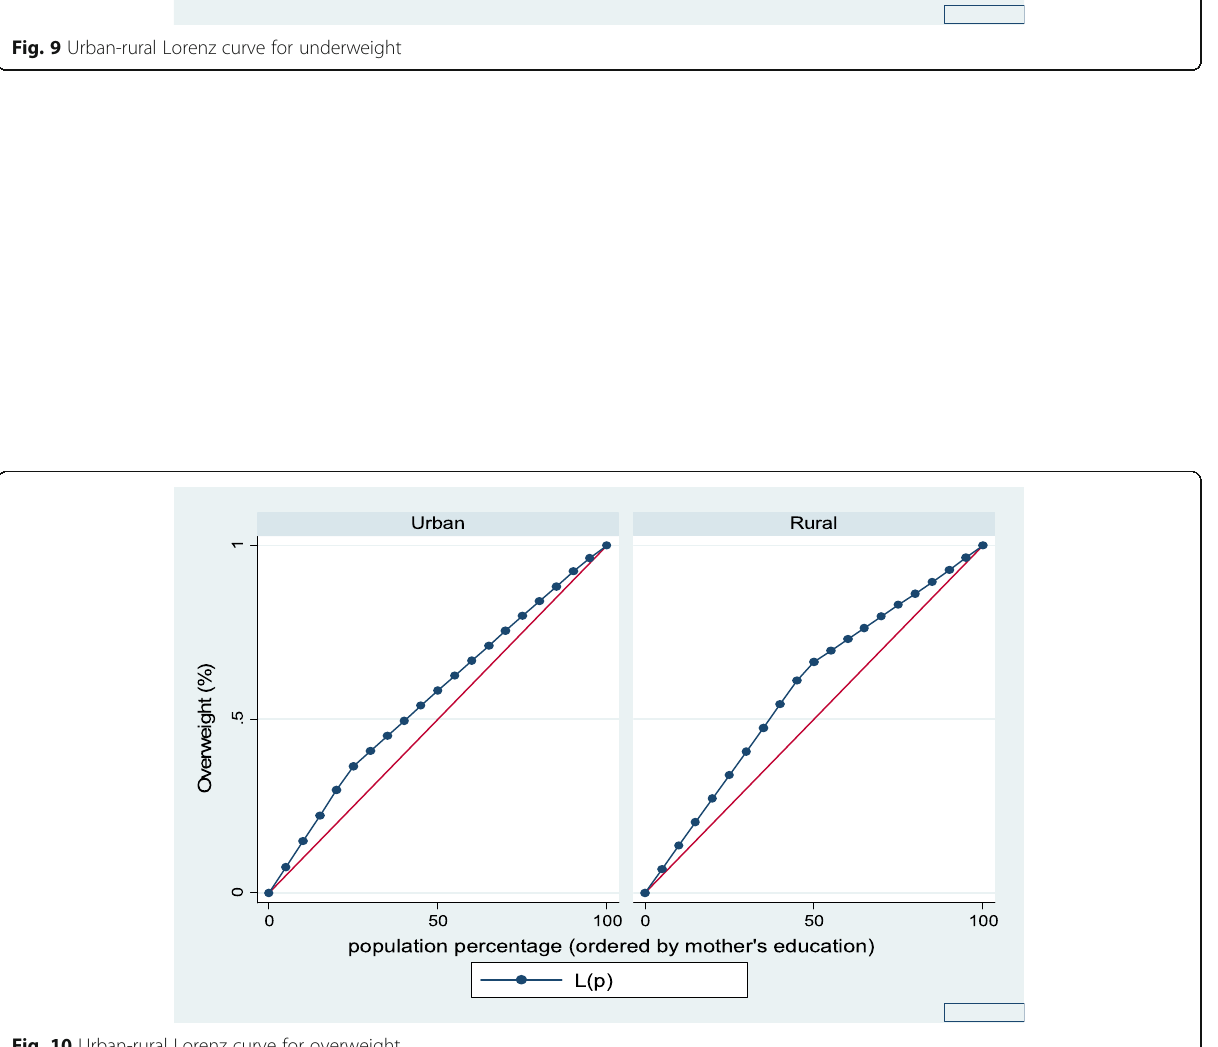
Fig. 10 Urban-rural Lorenz curve for